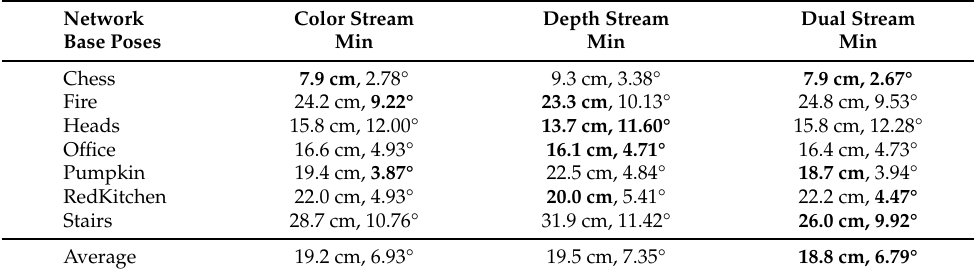
Table 8. Median translation error (cm) and rotation error (°) for different network architectures on 7 Scenes . Bold numbers indicate the lowest error value.